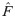
Dependence on w of the stable equilibrium behind the wave front.Fixed parameter values are a = 1, b = 1, s = 0.025, g = 0.375, p = 0.8, q = 0.1. Grey dots give the numerically-simulated normalized values of F^ for each value of w. Similarly, black dots connected by broken and solid lines give the values of C^ and H^, respectively. The brown dots give the numerically obtained speeds. Note the relevant equilibrium behind the wave front is E5 when w < p − s = 0.775 and E4 when the inequality is reversed. Similarly, the heuristically predicted speed is v=2a(1−w) when w < p − s = 0.775 and v=21+s−p when the inequality is reversed (Appendix 3). For E5, F^ is monotone decreasing in w, C^ is monotone increasing in w because p = 0.8 < 1, and H^ is monotone increasing in w.